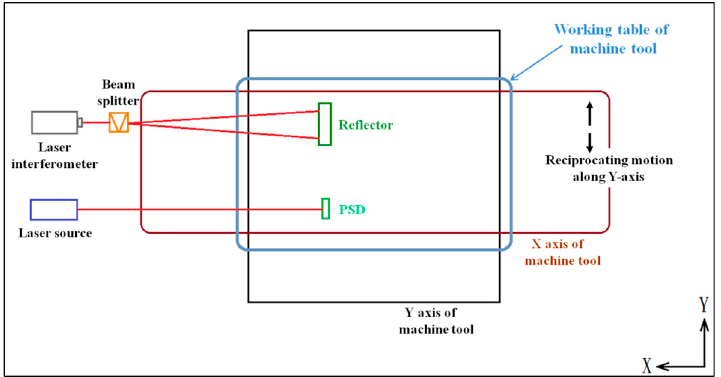
Figure 1. Schematic diagram of PSD calibration using laser interferometer.